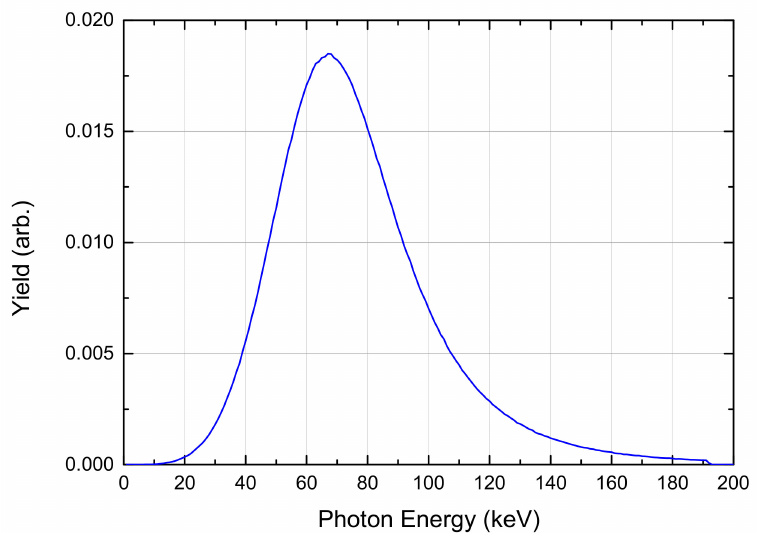
Figure 5. The initial synchrotron X-ray spectrum that was used as the energy distribution function for random initial photon energy